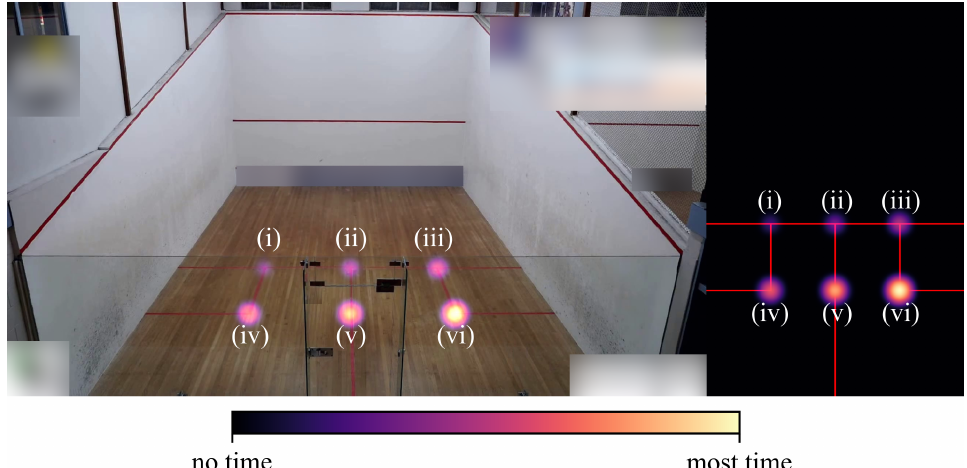
Figure 5. Synthetic heatmaps illustrating the use of a color scale to encode location and time. Heatmap overlaid on a video frame ( left ) and a virtual top-down view ( right ). (i)–(vi) indicate six different court locations and, by means of a color scale, the different durations of time for which a player occupied a location during matchplay. For better visualization, the gaussian kernel was used to increase the accumulator values, and was parameterized with 127 × 127 px and a standard deviation σ = 15 for this figure